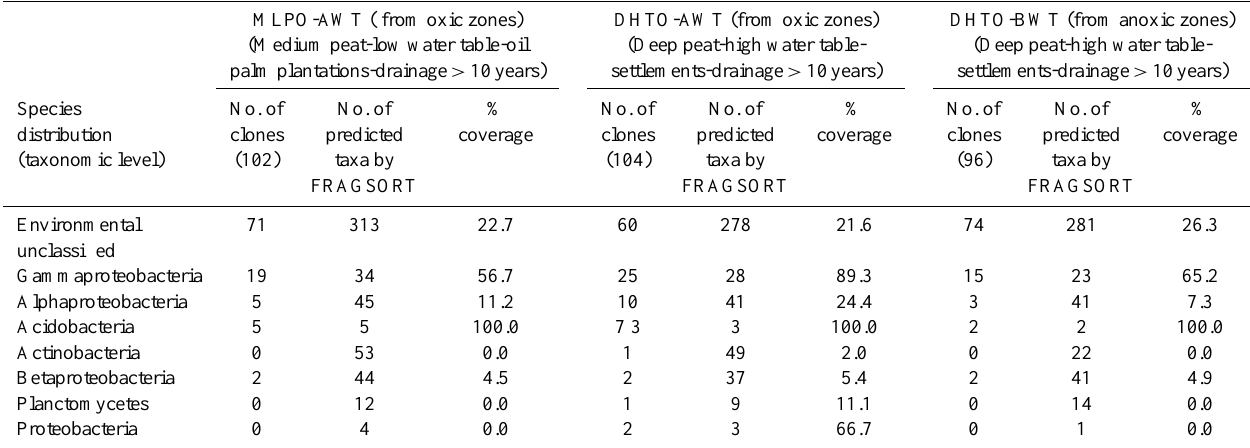
Table 3. Correspondence of clone data in comparison to predicted species. “AWT”: above-water-table samples; “BWT”: below-water-table